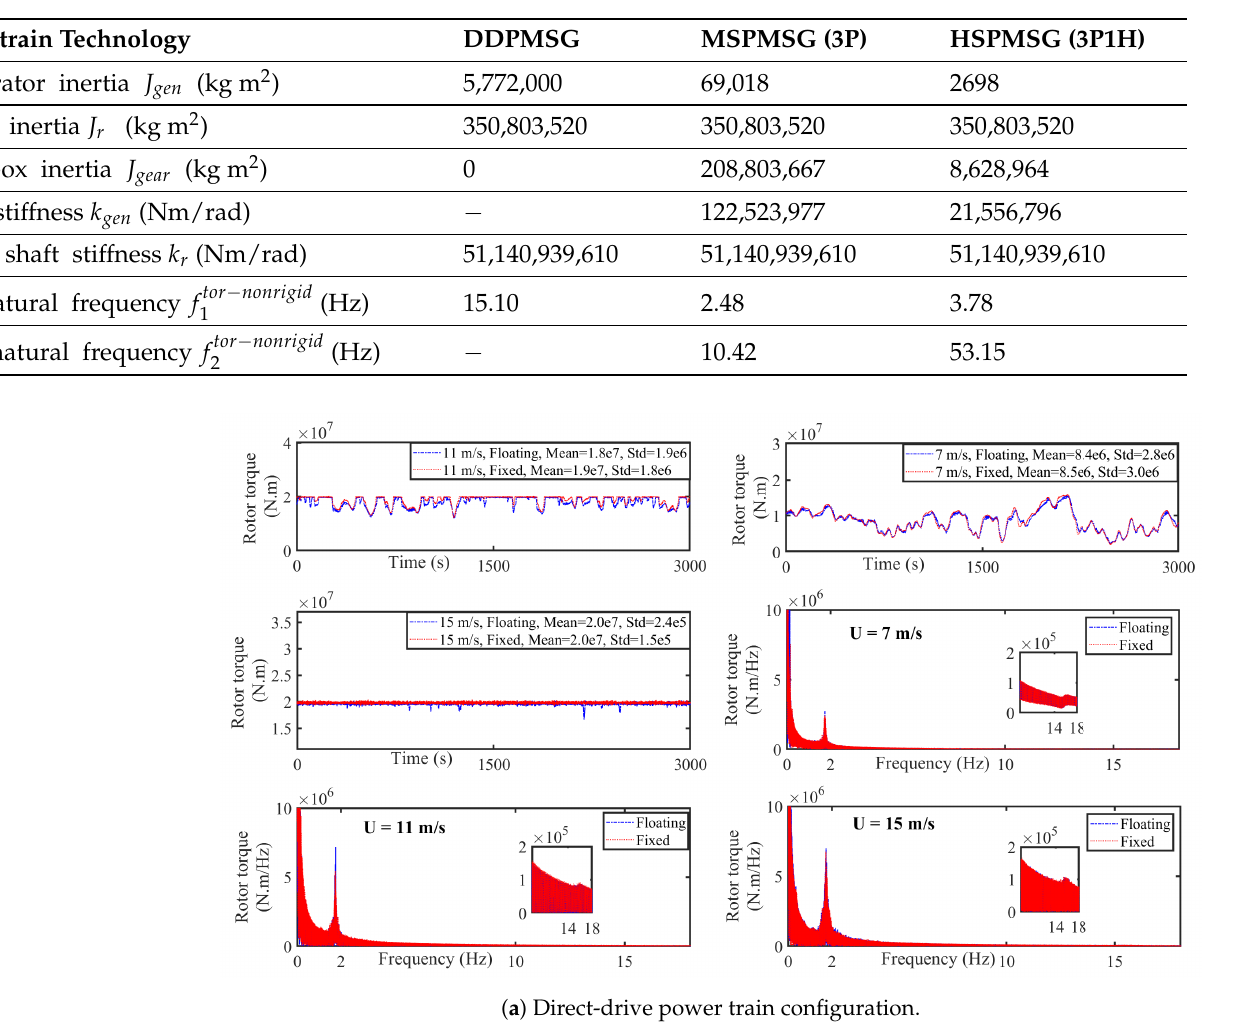
Table 11. Drivetrain equivalent dynamic model and natural frequencies.